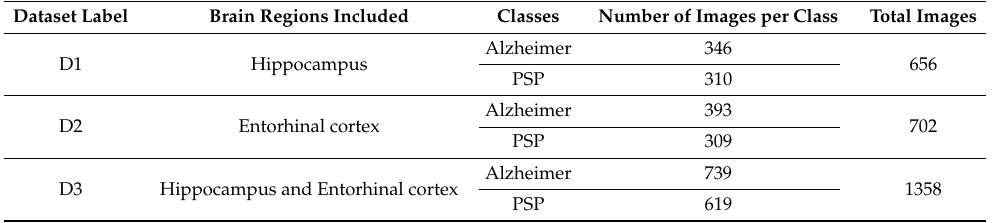
Table 1. Summary of datasets. Dataset